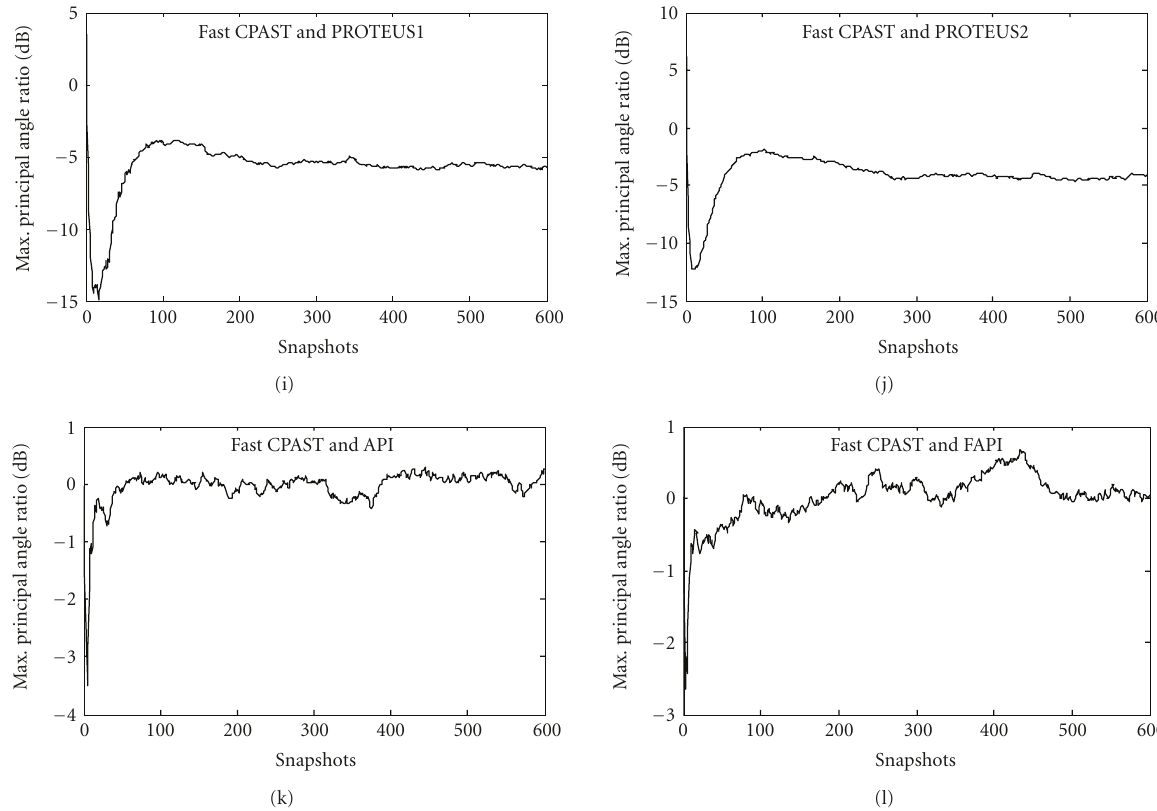
Figure 3: Ratio of maximum principal angles of fast CPAST and other algorithms in the first simulation scenario.